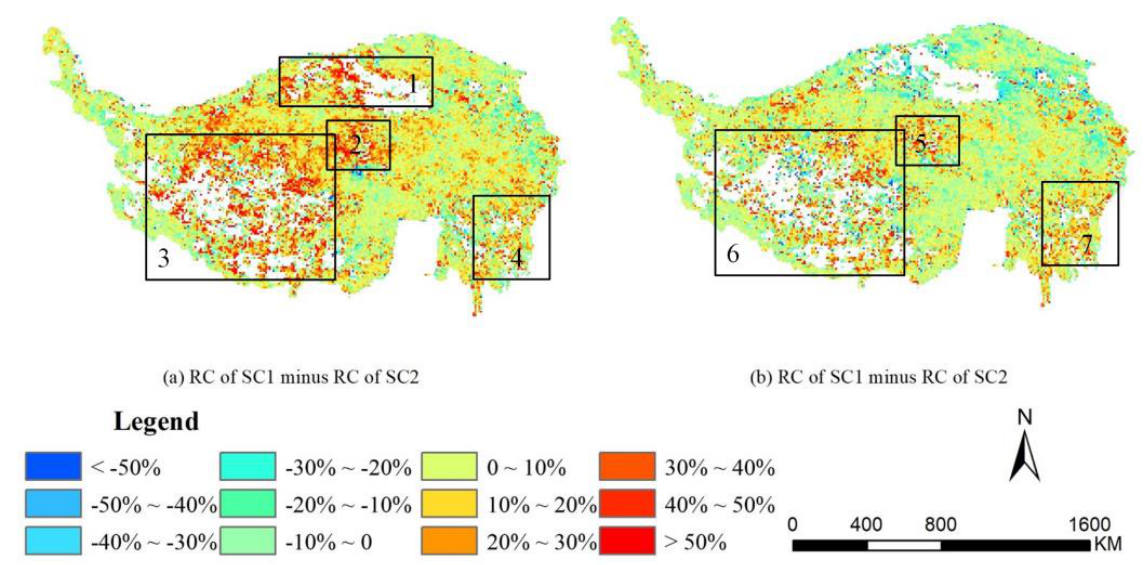
Figure 6. Spatial distribution of recall (RC) differences for cloud-gap-filled snow cover at the reso- lution of 10 × 10 km. SC1, SC2, and SC3 were the snow cover products of the combined MOD10A1F and MYD10A1F (SC1) developed by Huang et al. [28] and Qiu et al. [29], respectively.